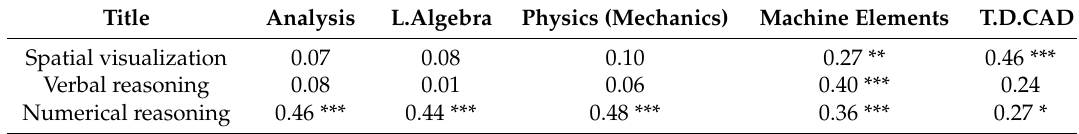
Table 7. Correlations between latent abilities and grades among engineering students.